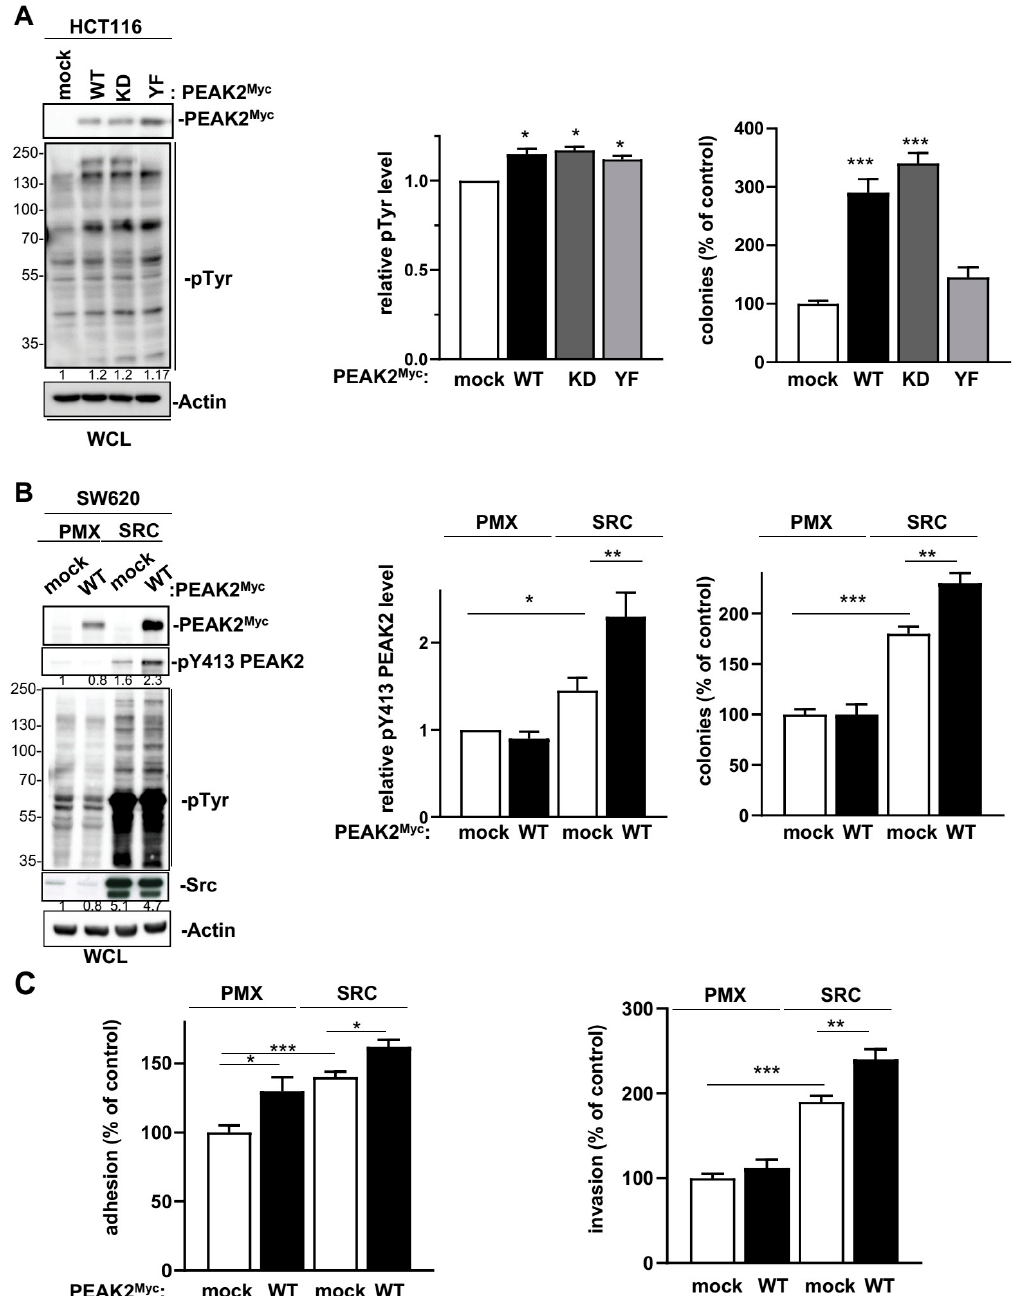
Figure 4. PEAK2 expression promotes CRC cell growth, adhesion and invasion. ( A ) PEAK2 expression increases growth of HCT116 CRC cells. Is shown the cellular protein tyrosine phosphorylation, PEAK2 protein levels and anchorage independent growth of HCT116 cells transduced with indicated PEAK2 constructs. The quantification of protein tyrosine phosphorylation and colonies formation in soft agar (% control) is shown from 3 independent experiments. ( B ) SRC expression promotes PEAK2 oncogenic function in SW620 CRC cells. Protein tyrosine phosphorylation, PEAK2 protein level and phosphorylation on Y413 and colonies formation in soft-agar of SW620 cells that were coinfected with SRC, PEAK2 Myc or control viruses (mock, PMX) as shown. The relative quantification of pY413 PEAK2 levels and colonies formation is shown from 3 independent experiments. ( C ) Adhesion on fibronectin and invasion in matrigel of indicated SW620 cells. Is shown the mean ± SEM; n = 3–4 * p < 0.05; ** p < 0.01; *** p < 0.001 (Student’s t